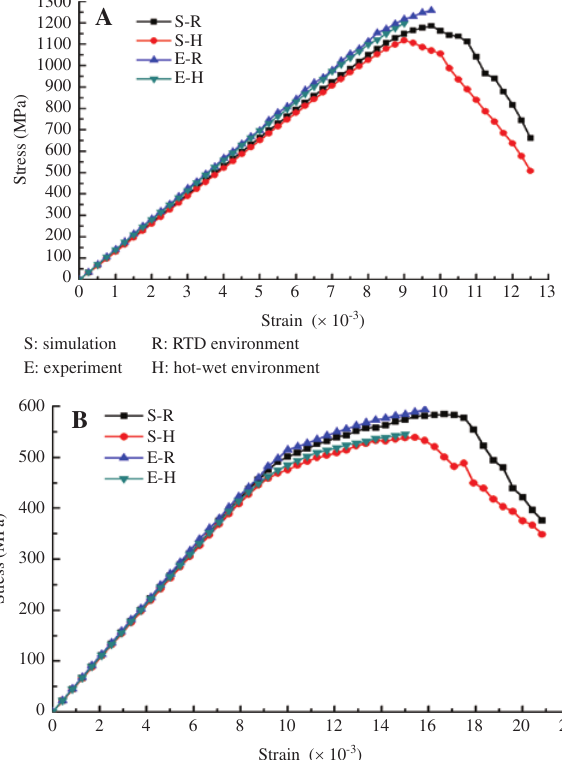
specimen and (B) the 6